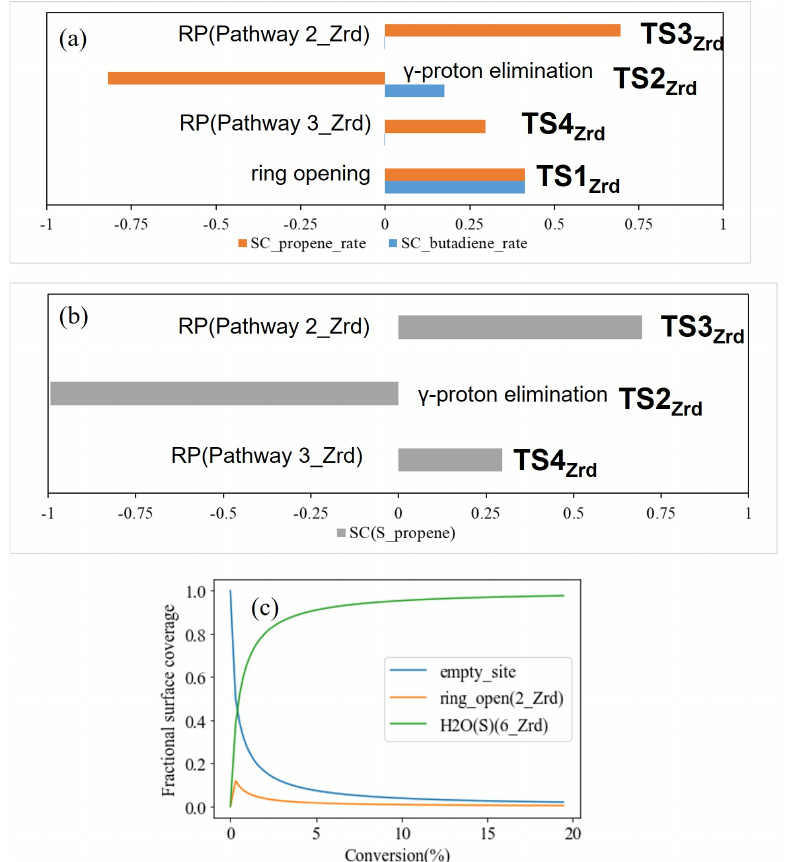
Figure 2. Microkinetic analysis of reaction on dry-ZrO 2 : ( a ) sensitivity analysis for product for- mation rates; ( b ) sensitivity analysis for propene selectivity; ( c ) surface coverages in predominant species vs. conversion. (TS: Transition State; SC: Sensitivity coefficient; RP: